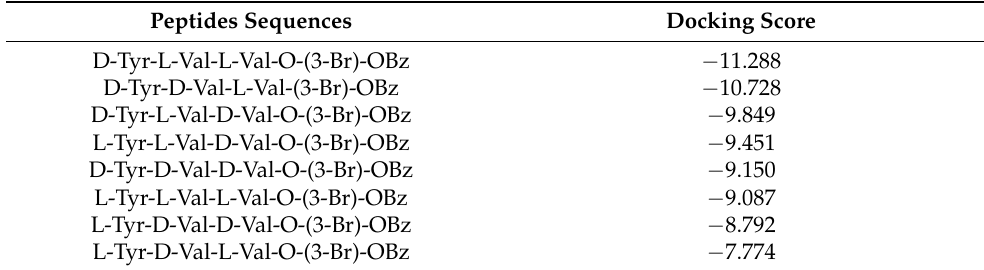
Table 3. Docking score values for the designed peptides based on the third